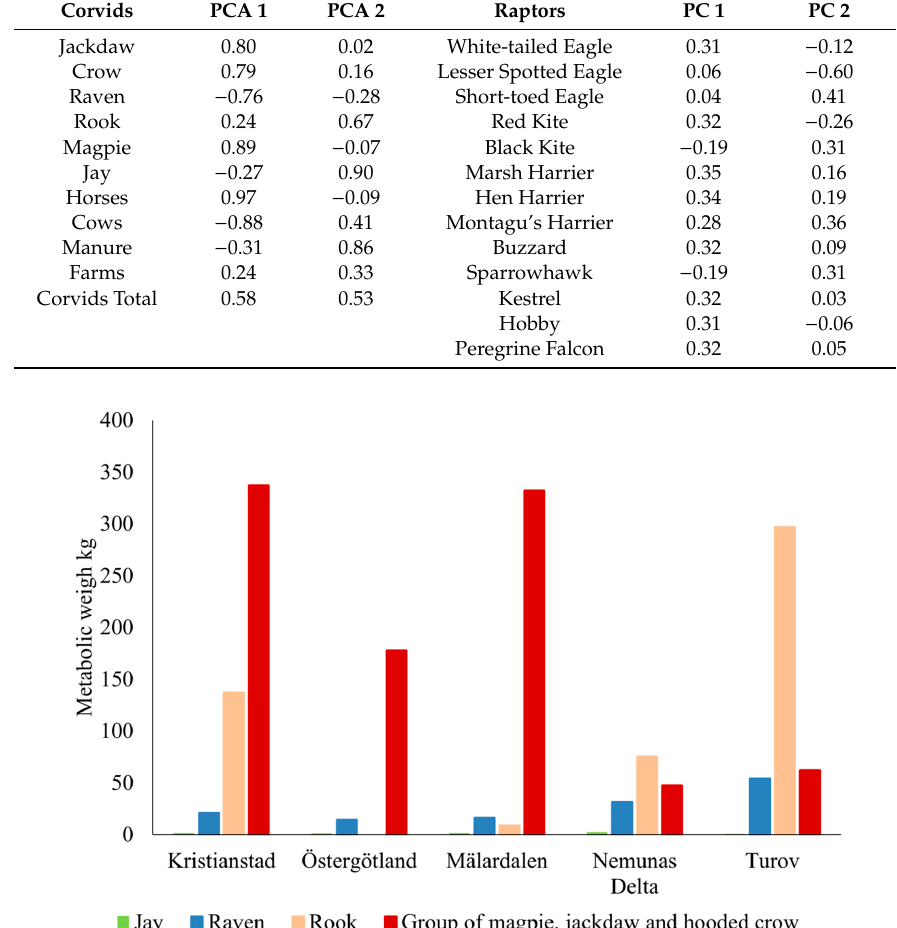
Figure 6. Landscape scale proxy of energy requirements for the four identified corvid bird groupings based on the PCA results for corvid bird species abundance and resources availability (Figure 5).